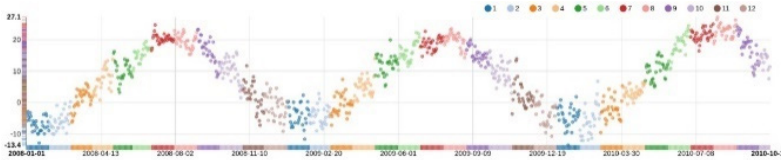
Figure 16. Visualization of monthly temperature in Kutchan-cho.